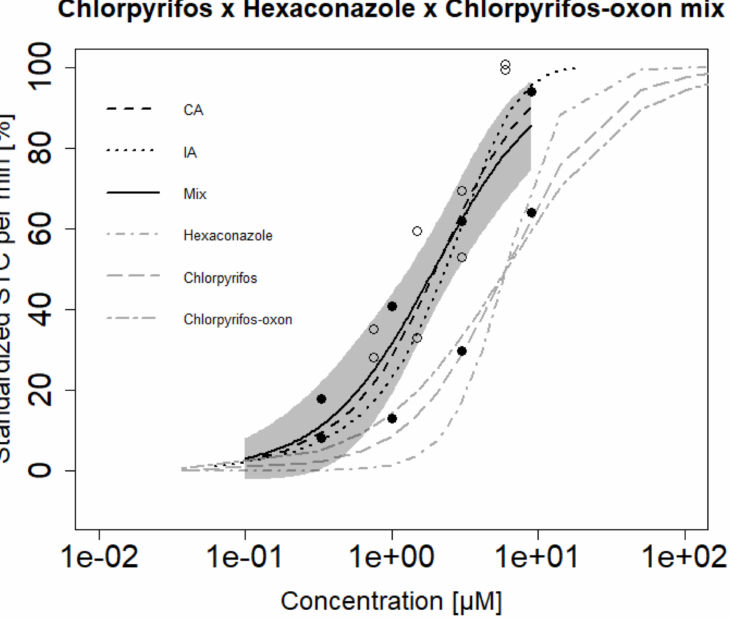
Figure 4. Comparison of observed (Mix) versus predicted effects of a ternary mixture based on the concentration addition (CA) and independent action (IA) models for mixture C. Furthermore, mixture effects are compared to single substances effects: Grey shaded areas represent the confidence interval of the fitted mixture model for the observed effect. Different symbols represent observed mean of STC effect for 20 embryos exposed in independent mixture